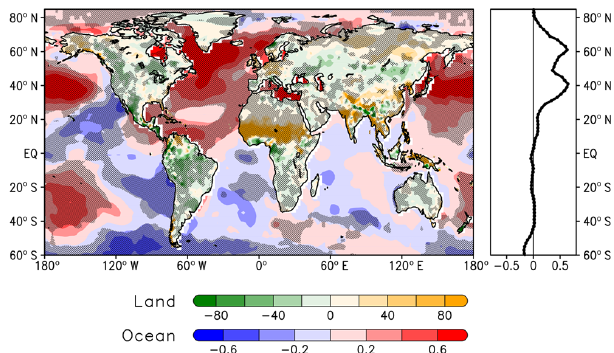
Figure 4. (Left) trend shifts in SST (K10 years − 1 ) and (right) lat- itude profile of its zonal mean. Land areas display trend shifts in JAS precipitation from Fig. 3a. Hatching represents areas where trends changed sign between the two parts of the study period (tan θ 1 · tan θ 2